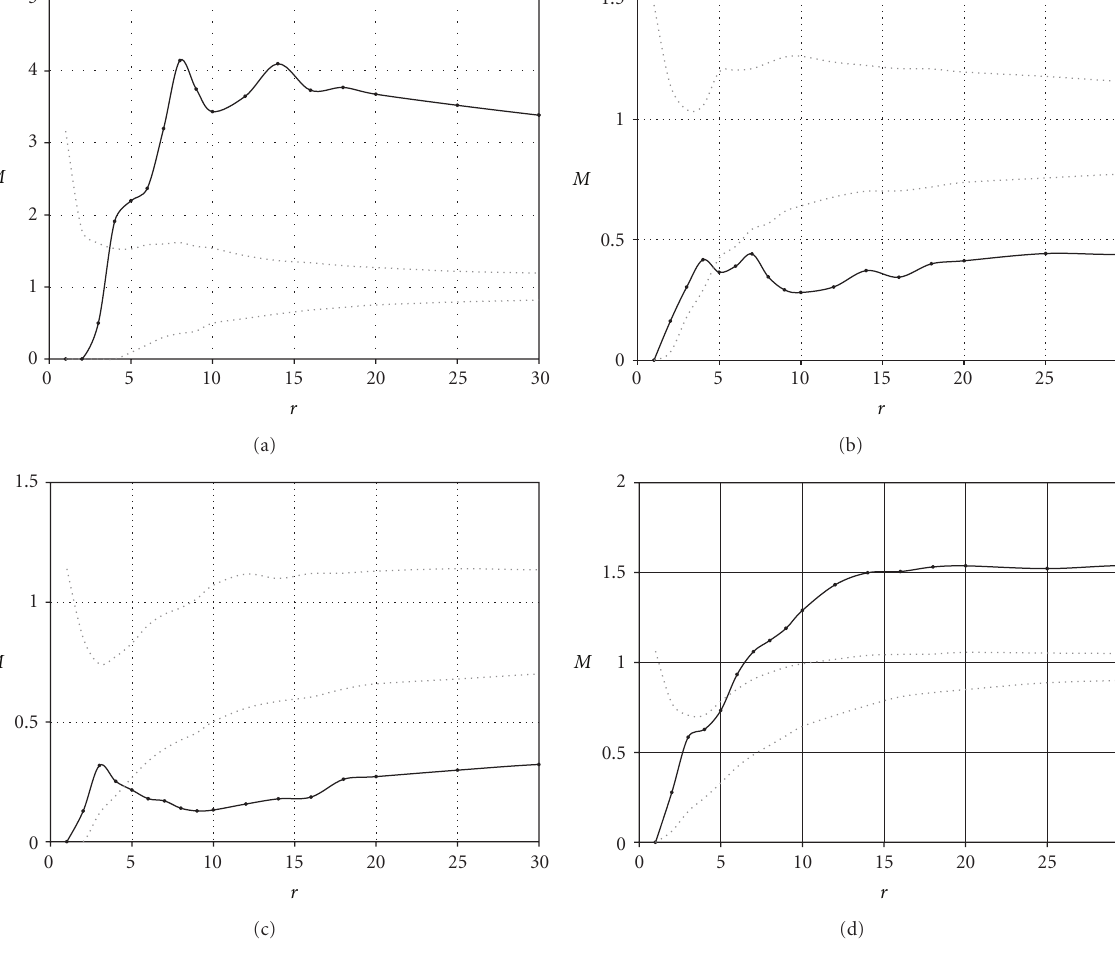
Figure 9: Spatial structure of Vouacapoua americana ((a) univariate M function) and Qualea rosea ((d) univariate M function), and bivariate M M functions ((b) M Va , Qr and (c) Qr , Va ). Confidence intervals are computed at 1% risk level. Both species are aggregated over around 5 meters, and they significantly repulse each